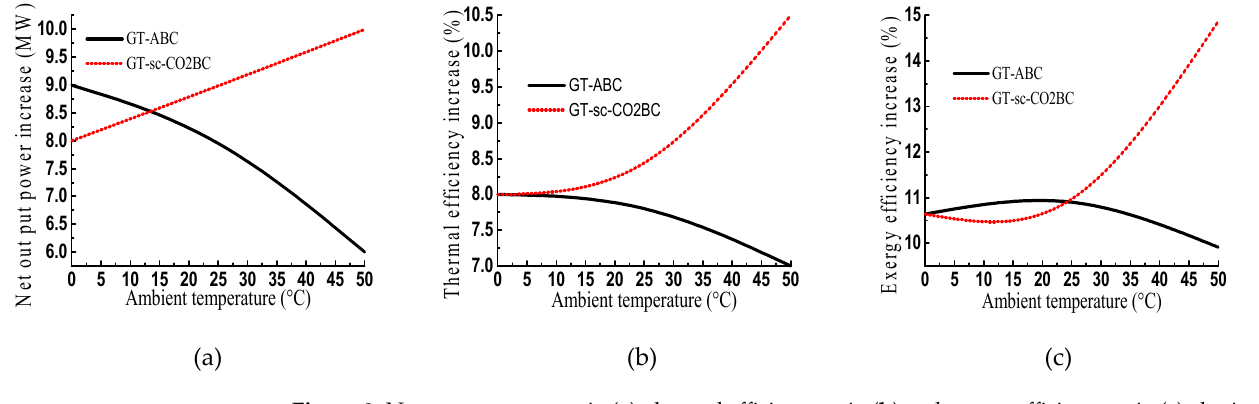
Figure 8. Net output power gain ( a ), thermal efficiency gain ( b ) and exergy efficiency gain ( c ) obtained with GT-ABC and GT-sc-CO2BC compared with ASC versus ambient temperature (bottoming cycle pressure ratio = 3.3 and gas mass flow rate = 390 kg/s).